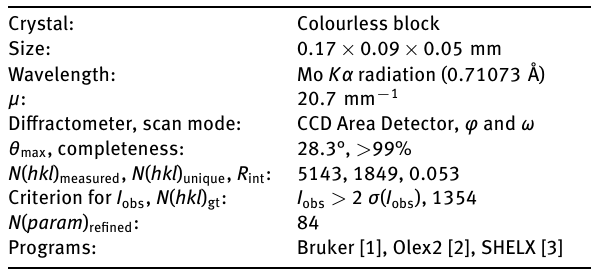
Table 2: Fractional atomic coordinates and isotropic or equivalent isotropic displacement parameters (Å 2